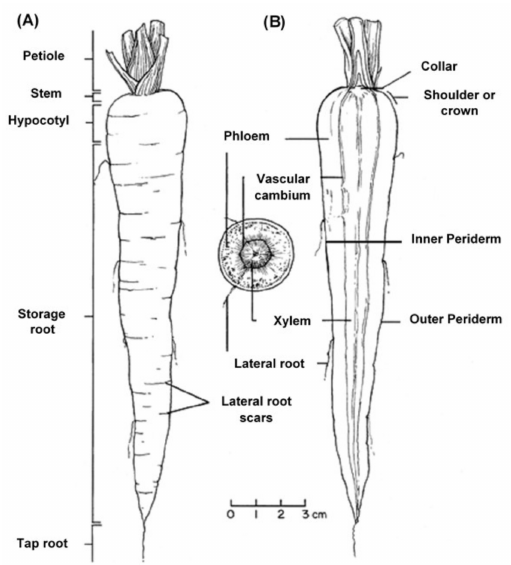
Figure 1. Carrot root anatomy: ( A ) longitudinal; ( B ) cross-section, showing the periderm, phloem, and xylem (www.carrotmuseum.co.uk).